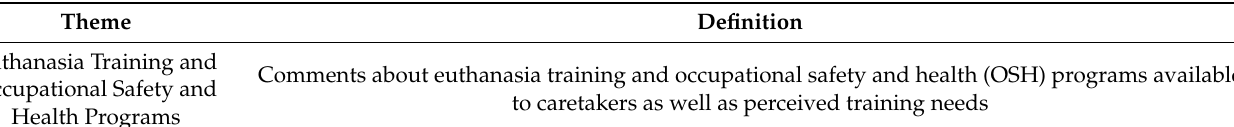
Table 2. Themes and definitions used for coding of focus groups and interview